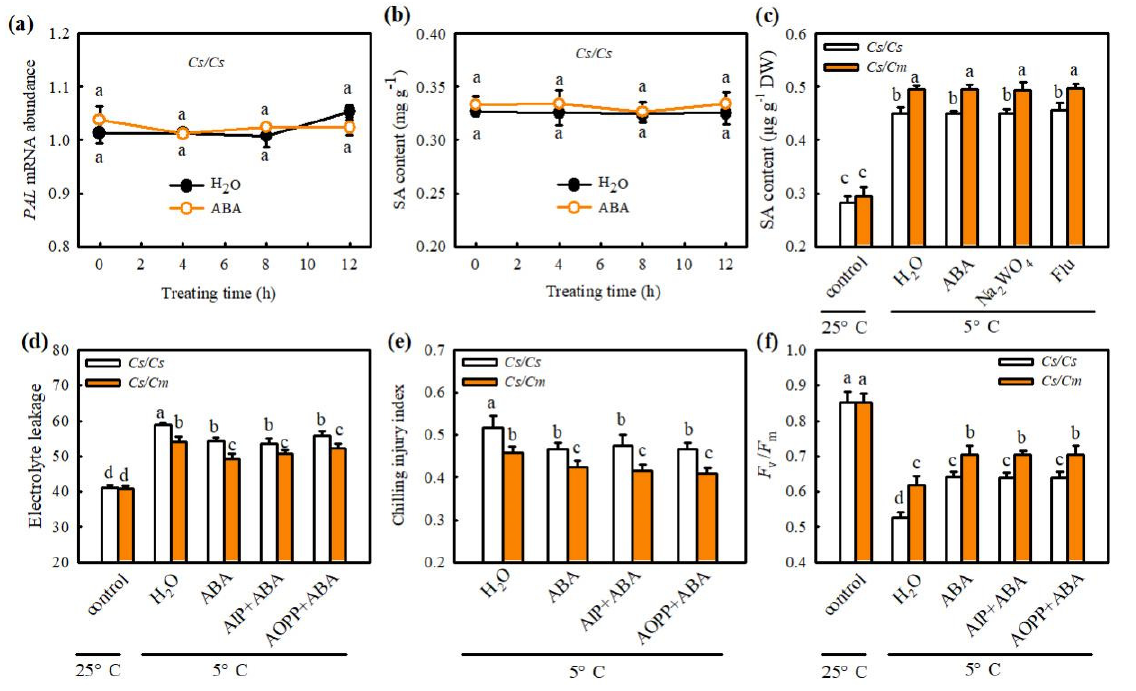
Figure 6. Effect of ABA on the SA biosynthesis and the role of SA − in ABA − induced chilling tolerance in grafted cucumber. ( a , b ) PAL mRNA abundance and SA content, respectively, in Cs / Cs leaves. The Cs / Cs cucumber were pretreated with 50 µ M ABA or distilled water (control), and then the changes of PAL mRNA abundance and SA content were measured within 12 h. ( c ) SA accumulation in Cs / Cs or Cs / Cm after chilling treatment for 0 h and 12 h. Plants were foliar sprayed with 50 µ M ABA, 3 mM Na 2 WO 4 , 50 µ M Flu, or distilled water (control) for 12 h and then exposed to chilling stress. ( d ) Electrolyte leakage of grafted plants after chilling treatment for 0 h and 48 h. ( e ) Chilling injury index of grafted plants before and after chilling treatment for 72 h. ( f ) F v / F m of Cs / Cs or Cs / Cm plants after chilling treatment for 0 h and 48 h. Plants were treated with 50 µ M ABA, 30 µ M AIP + 50 µ M ABA, 0.1 mM AOPP + 50 µ M ABA, or distilled water (control) for 12 h and then exposed to chilling stress. Data are presented as the means ± SD ( n = 3). Different letters indicate a statistical significance between samples at p <